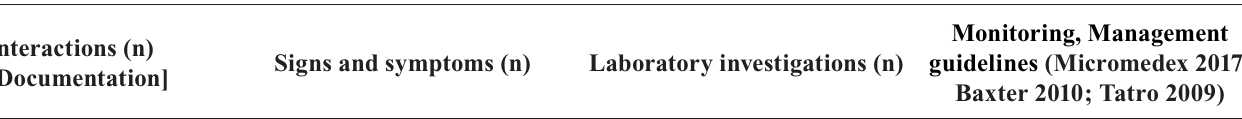
TABLE VI - Top ten interactions, their documentation, clinical relevance and monitoring/management guidelines